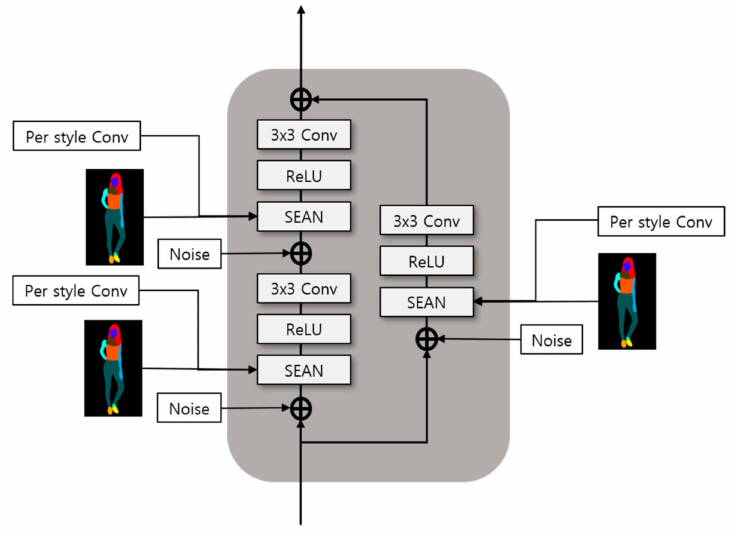
Figure 6. Structure of SEAN ResBlK.